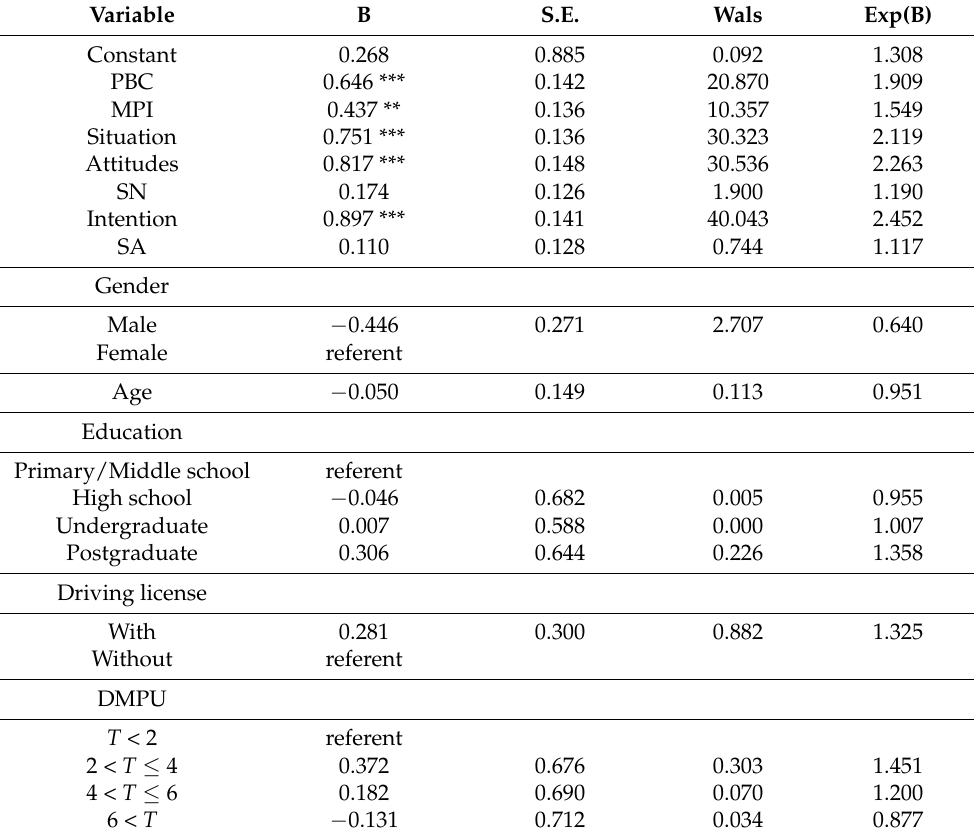
Table 6. Binary logistic regression model predicting the